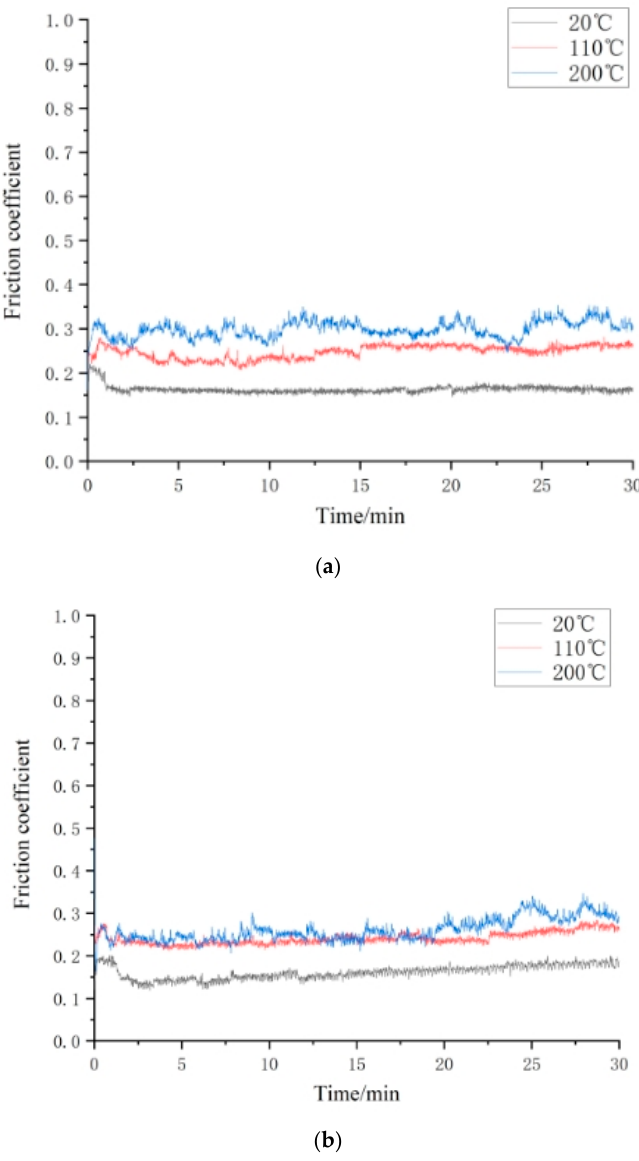
Figure 5. Friction coefficient at different temperatures. ( a ) Friction coefficient of the hardened layer after laser hardening with a scanning speed of 700 mm/min. ( b ) Friction coefficient of the hardened layer after laser hardening with a scanning speed of 800 mm/min.